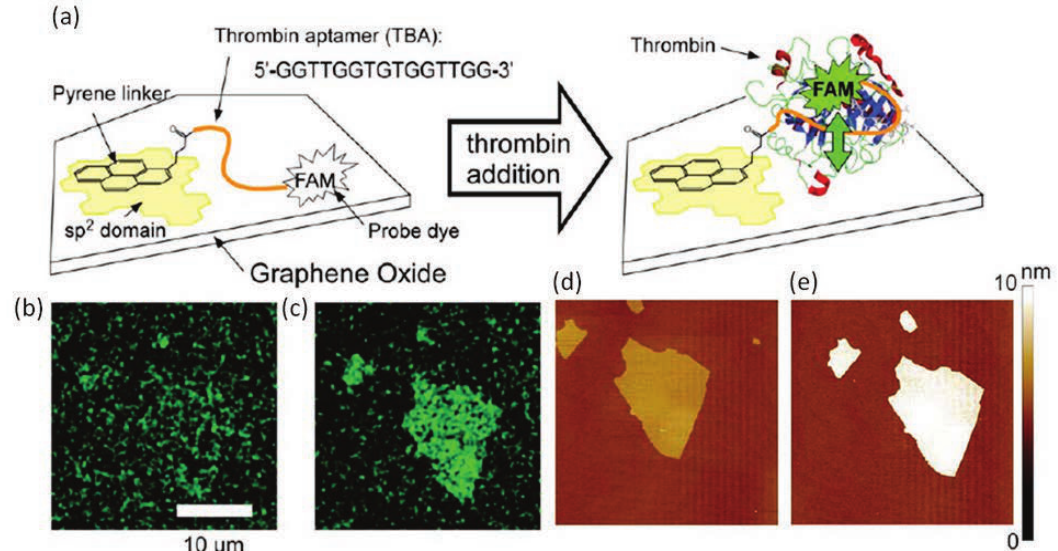
Figure 16. (a) Schematic illustration of the modified GO surface and the principle of thrombin detection. (b) before thrombin addition. (c) 80 s after thrombin addition. (d) and (e) are the AFM topographies of the GO piece in (b) and (c), respectively. Reprinted with permission from [78]. Copyright 2013 Royal Society of Chemistry